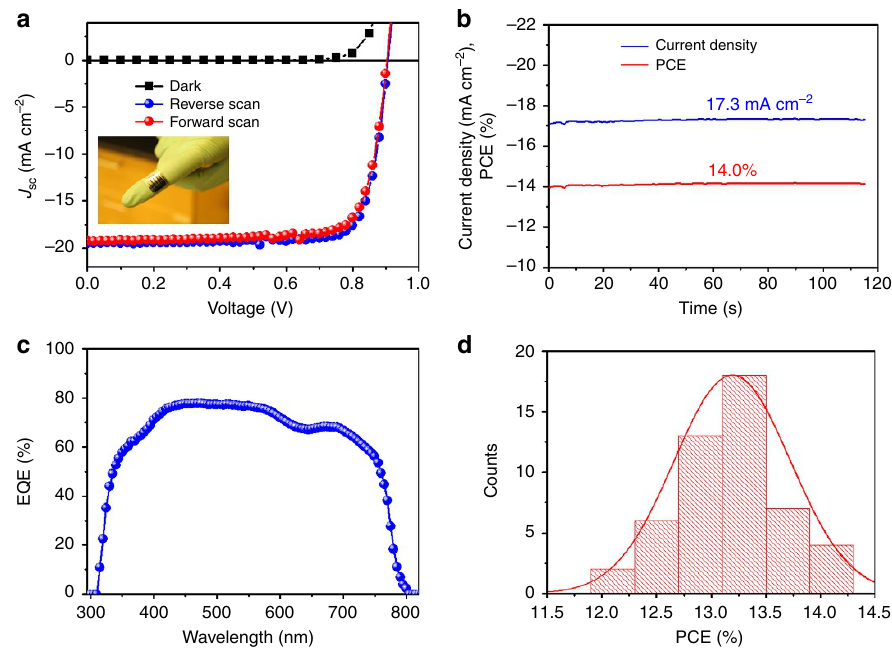
Figure 3 | Photovoltaic performance characteristics. ( a ) J – V curves in reverse and forward scan measured under 100mWcm (cid:2) 2 AM 1.5G illumination and dark for the champion flexible PET/Ag-mesh/PH1000/PEDOT:PSS/MAPbI 3 /PCBM/Al solar cell: Inset shows photograph of corresponding ultra-thin flexible pero-SCs. ( b ) Steady-state photocurrent output at the maximum power point (0.8V). ( c ) External quantum efficiency (EQE) spectrum of champion flexible pero-SC. ( d ) Histograms of device PCE measured for 50 devices of PET/Ag-mesh/PH1000/PEDOT:PSS/MAPbI 3